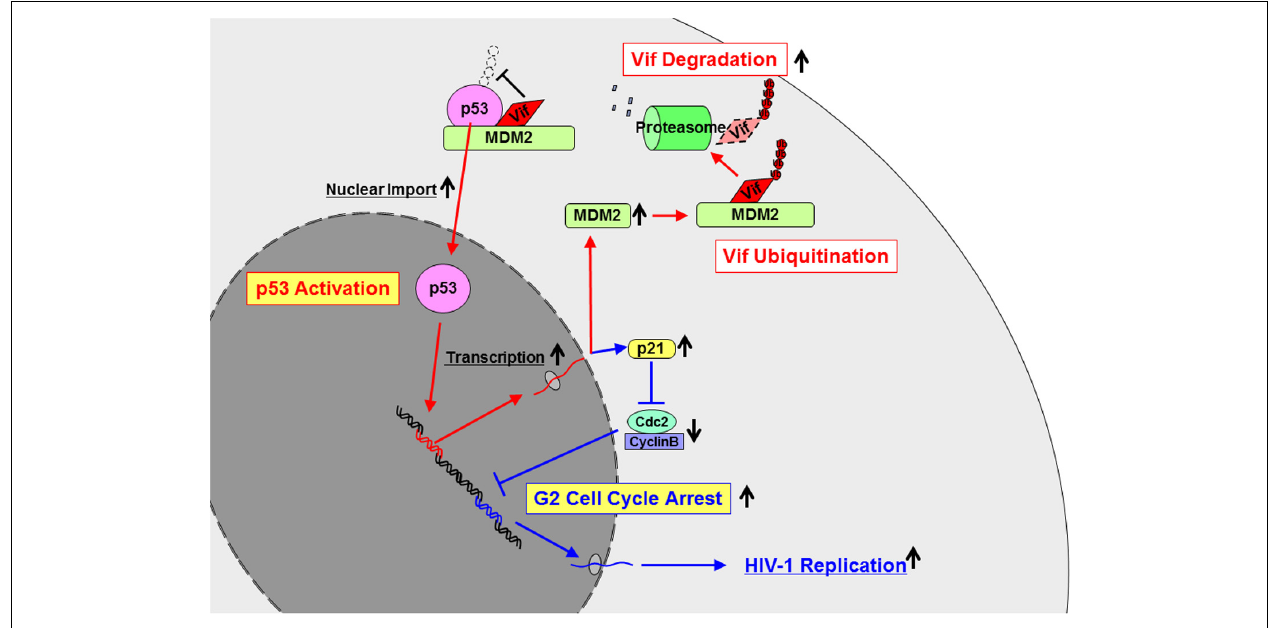
several genes including MDM2 and p21. Enhanced expression of MDM2 may lead to moreVif ubiquitination and degradation, which forms the autoregulatory circuit ofVif expression. On the other hand, activation of p21 leads to G2 cell cycle arrest, resulting in more HIV-1 replication.